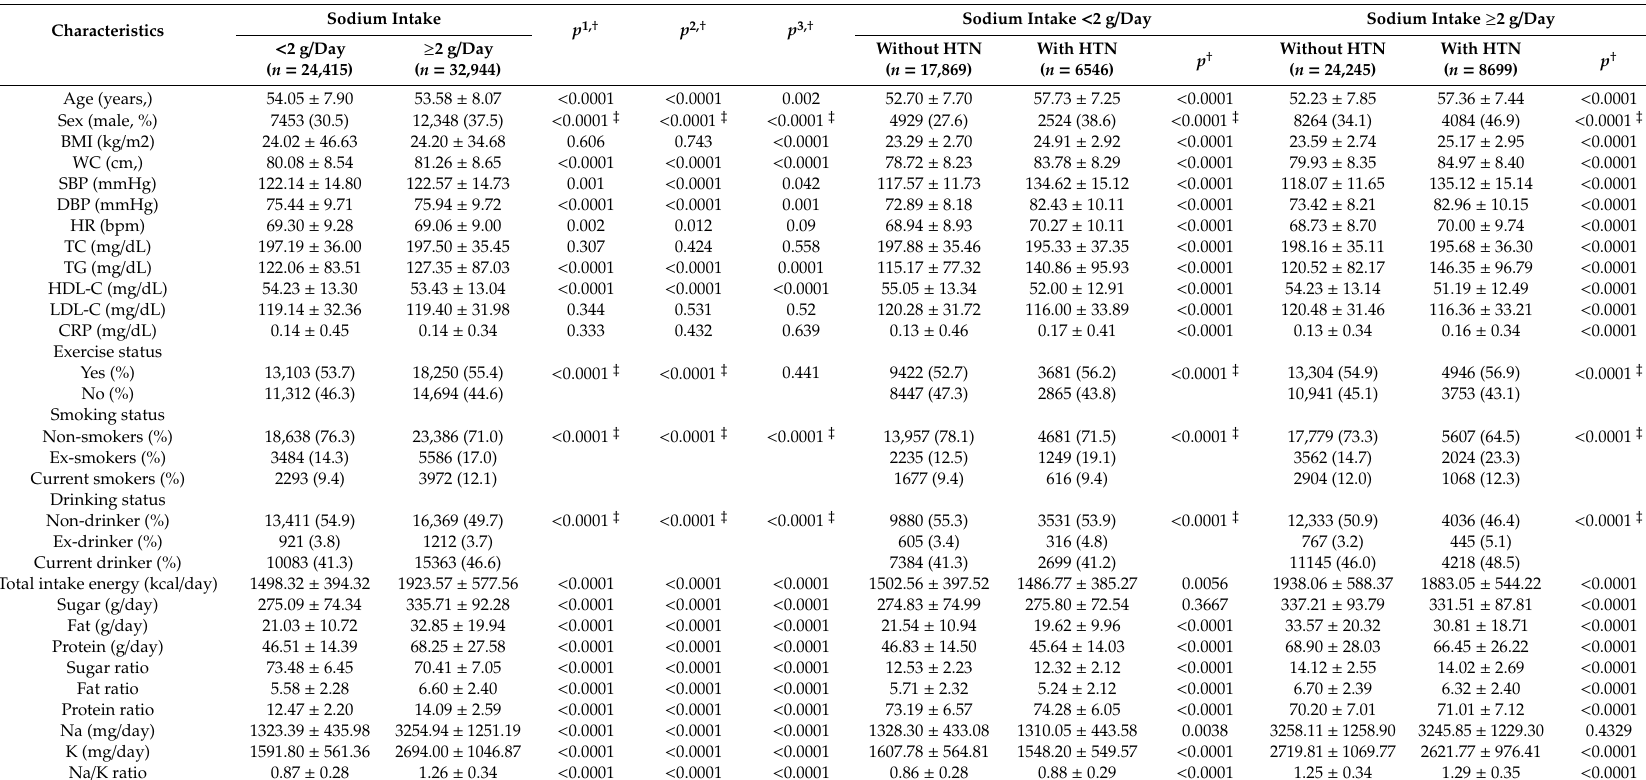
Table 1. General characteristics of study population based on sodium intake and according to prevalence of